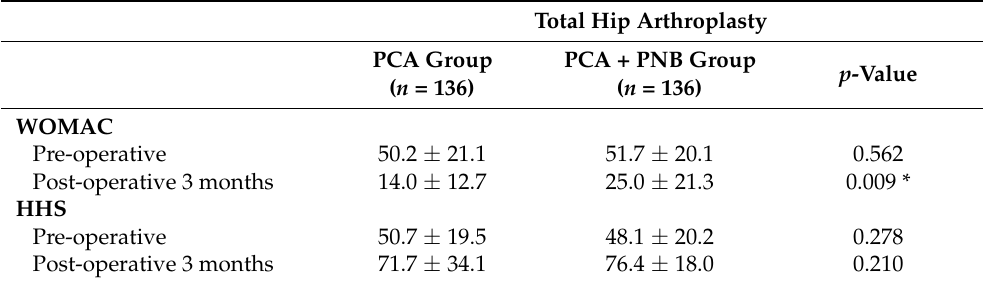
Table 2. Comparison of the functional outcomes with the WOMAC index and HHS between the PCA and PCA + PNB groups with total hip arthroplasty.